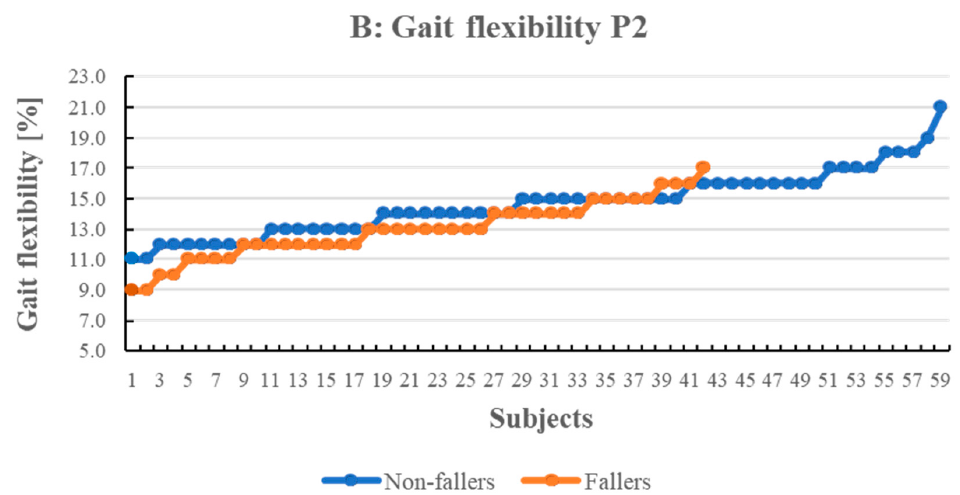
Figure 6. Gait flexibility for ( A ) P1 and ( B ) P2 obstacle courses. P1 = walking the obstacle course without walking down the stairs; P2 = walking in the total obstacle course.